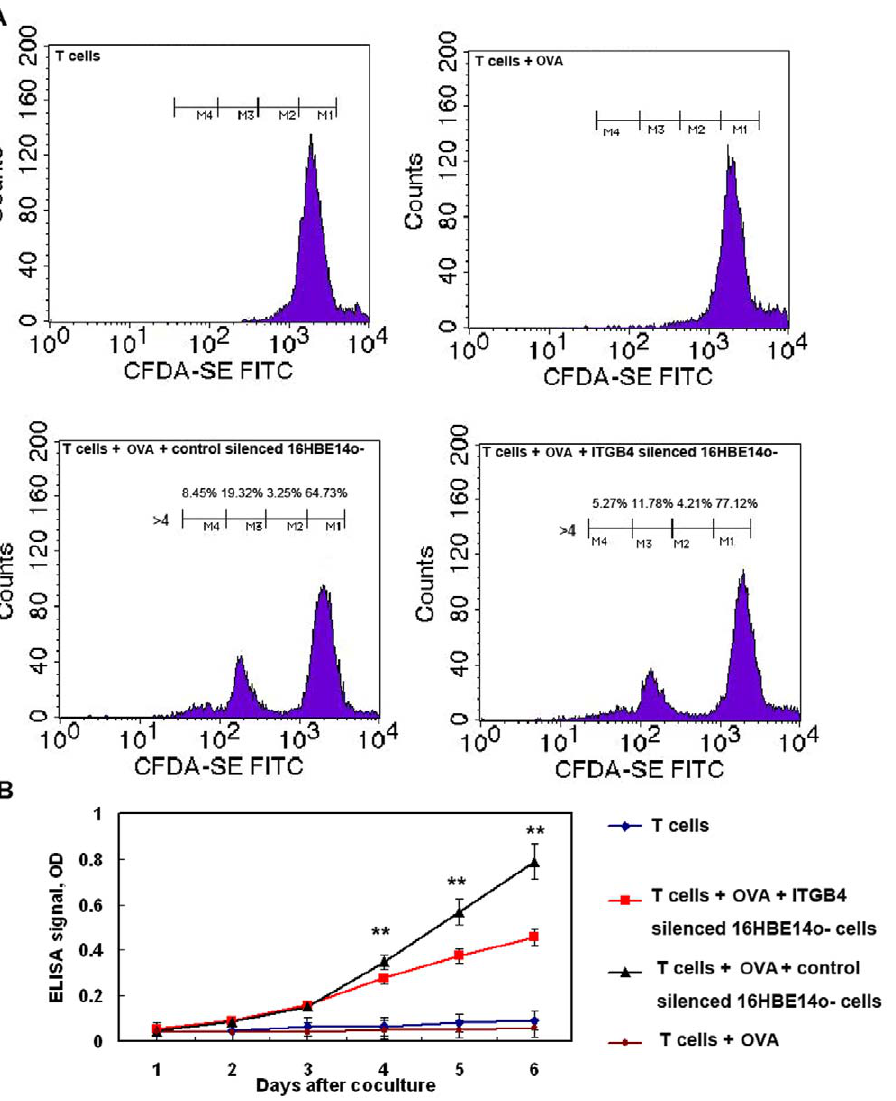
Figure 4. T cell proliferation was observed after coculturing T cells with control transfected 16HBE14o- cells or ITGB4-silenced cells. (A) On the basis of decreased CSFE staining, T cell proliferation are shown as percentage of proliferating cells, and are representative of one experiment repeated six times. Percentage of dividing cells (cells that have undergone 1 division) is shown for control silenced 16HBE14o- cells + T cells and ITGB4 silenced 16HBE14o- cells + T cells cocultures. Proportion of original population induced to divide after stimulation was determined by measuring the number of events in each cell division. (B) Meanwhile, T cell proliferation was assessed by a BrdU incorporation assay after coculture. The data are expressed as the mean ( 6 SEM) values of the specific absorbance from 10 independent experiments.